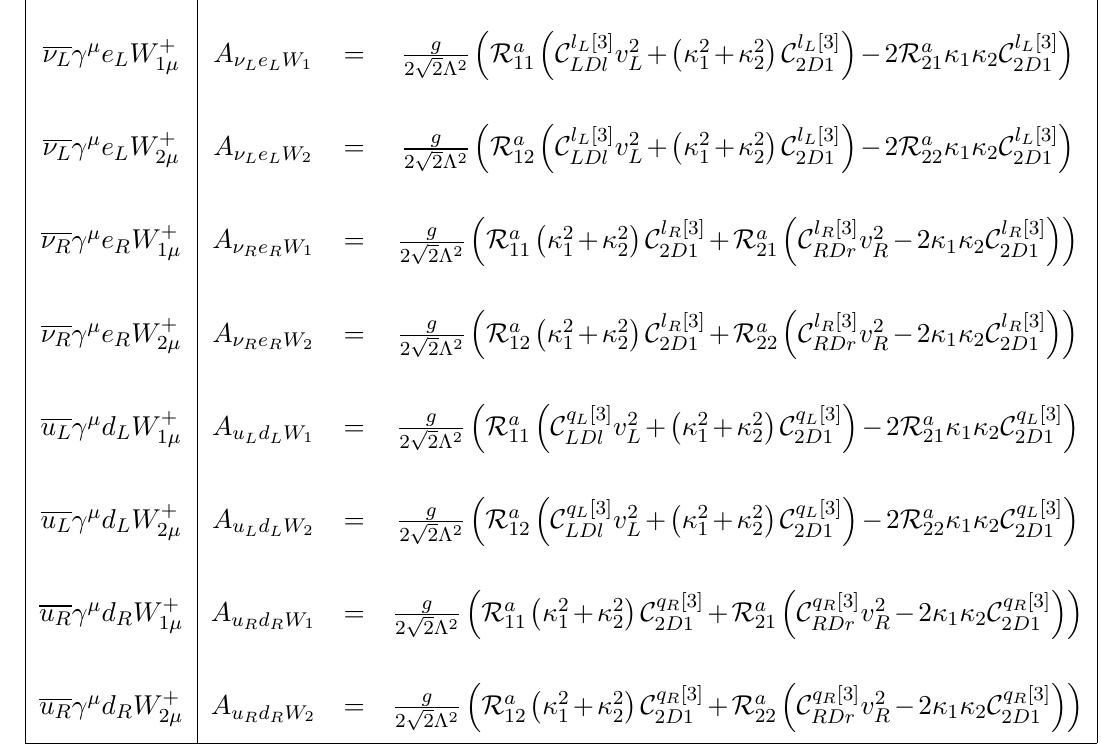
Table 30. MLRSM: corrections to the coupling of charged gauge bosons to fermions due to 2 (cid:30) 2 D